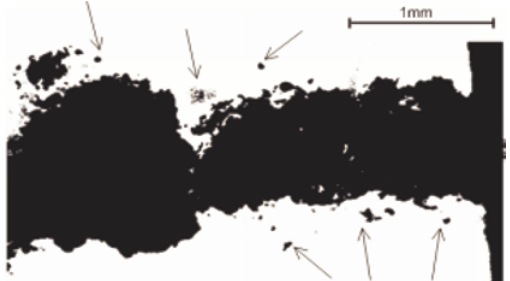
Fig. 8. Detail of a cavitating jet (flow from right to left).